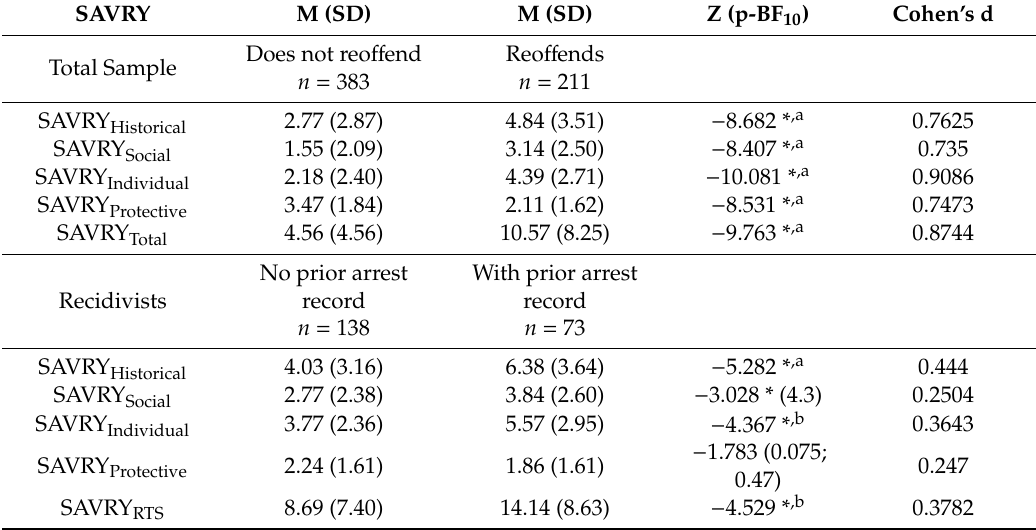
Table 2. Descriptive statistics, nonparametric contrasts of means ( U ) and estimated e ff ect